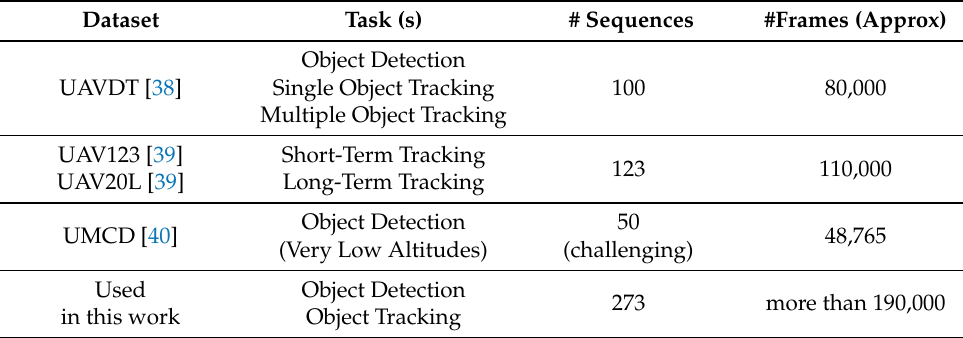
Table 1. Summary table of the exploited